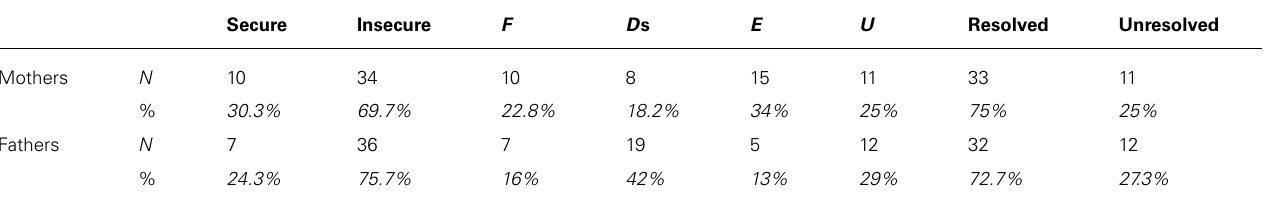
Table 1 | Frequencies and percentage for mothers and fathers onAAP attachment patterns. Secure